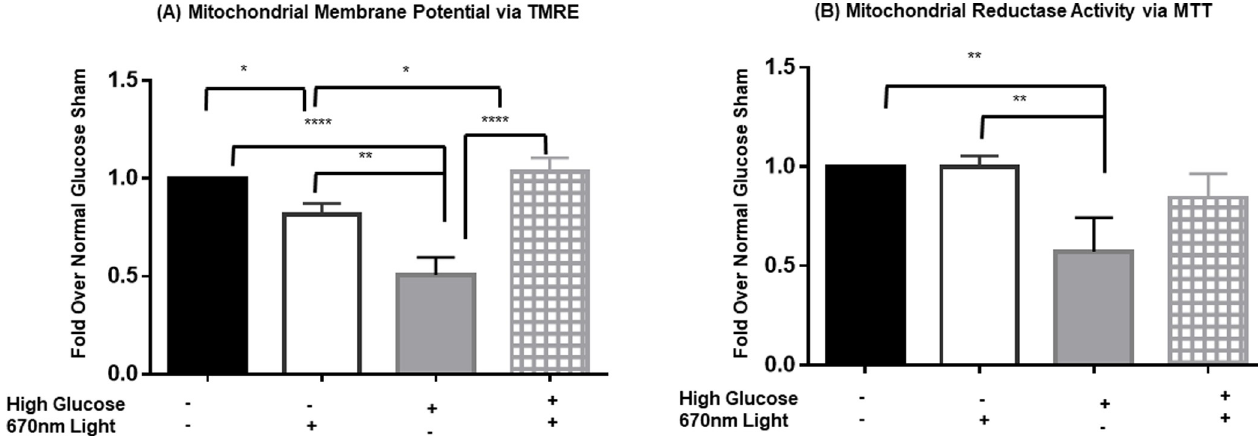
Fig 3. 670nm PBM restores mitochondrial function under high glucose conditions. rMC-1 cells were cultured in either normal glucose (black bars and white bars) or high glucose medium (gray bars and hashed bars) for 24 hours. 670nm (white bars and hashed bars) or sham control (black bars and gray bars) was applied to the cells at 4.5 J/cm 2 . All assays were normalized to the normal glucose sham levels. (A) Mitochondrial membrane potential was analyzed using TMRE, (B) NAPDH-dependent oxidoreductase activity was analyzed using MTT. Both TMRE and MTT assays were performed in 3 separate experiments, each data point was measured in triplicate. One-way ANOVA analysis yielded statistics as follows: � p < 0.05, �� p < 0.01, ���� p <